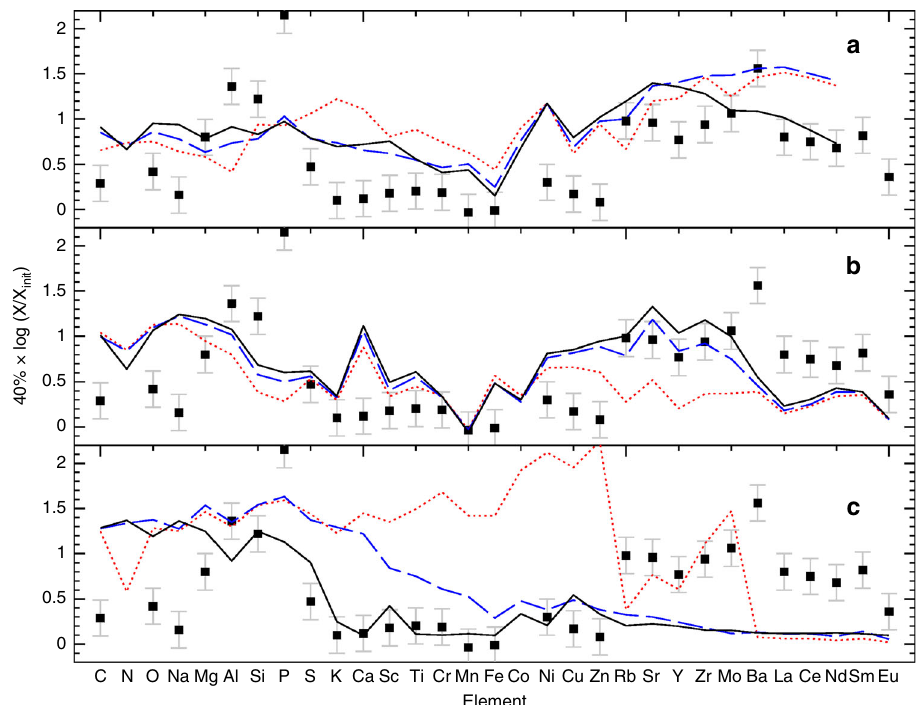
Fig. 7 Predictions of overabundance factors for massive star models against the abundance pattern of the P-rich star 2M13535604 + 4437076. Error bars show measurement uncertainties such as displayed in Supplementary Table 3. a Z = 0.001, 15, 20, 25 M ⊙ models (respectively dotted red, long- dashed blue and solid black lines) from ref. 26 with rotation. b Z = 0.001, 15, 20, 25 M ⊙ models (respectively dotted red, long-dashed blue and solid black lines) from ref. 27 with rotation. c Z = 0.001 15, 20, 25 M ⊙ models (respectively dotted red, long dashed blue and solid black lines) from ref. 28 with O – C shell mergers. A rough dilution factor of 40% has been applied to all model yields.